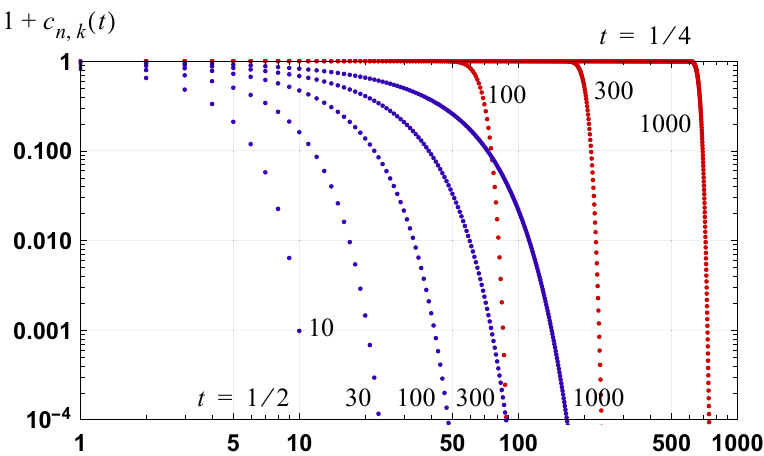
Figure 5. Graph of , for the case of and and for and . Results .1 Figure 5. Graph of 1 + c n , k ( t ) , for the case of α = 0 and β = 1 and for t = 1/4 and t = 1/2. Results are shown for n ∈ { 10,30, 100, 300, 1000 } when t = 1/2 and n ∈ { 100, 300, 1000 } when t = are shown for when and when